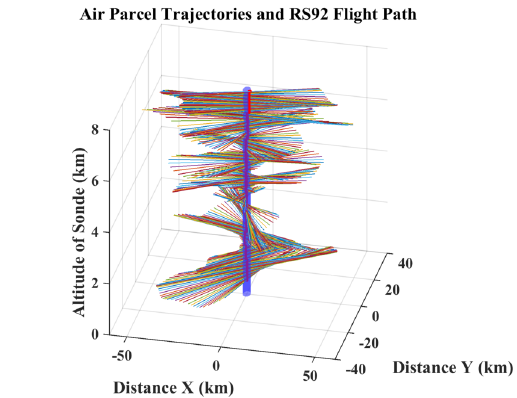
Figure 1: 4-hour 2D Air Mass Trajectories initialized from the radiosonde position (red line). The length of the trajectories is determined by the wind speed measured by the radiosonde GPS tracking. The blue cylinder represents the assumed horizontally homogeneous region around the lidar. We have chosen the radius to be 2 km.